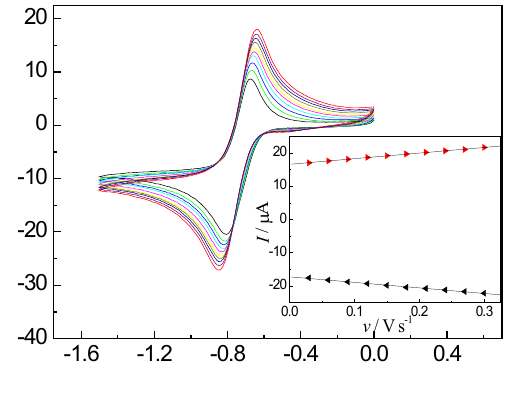
Figure 2. CVs of Zn-CPE in 0.1 M, pH 6.1, B-R buffer solution. Curves (a–j) correspond to the scan rates 0.03, 0.06, 0.09, 0.12, 0.15, 0.18, 0.21, 0.24, 0.27 and 0.30 V s -1 , respectively. Inset: the peak current versus scan rate.